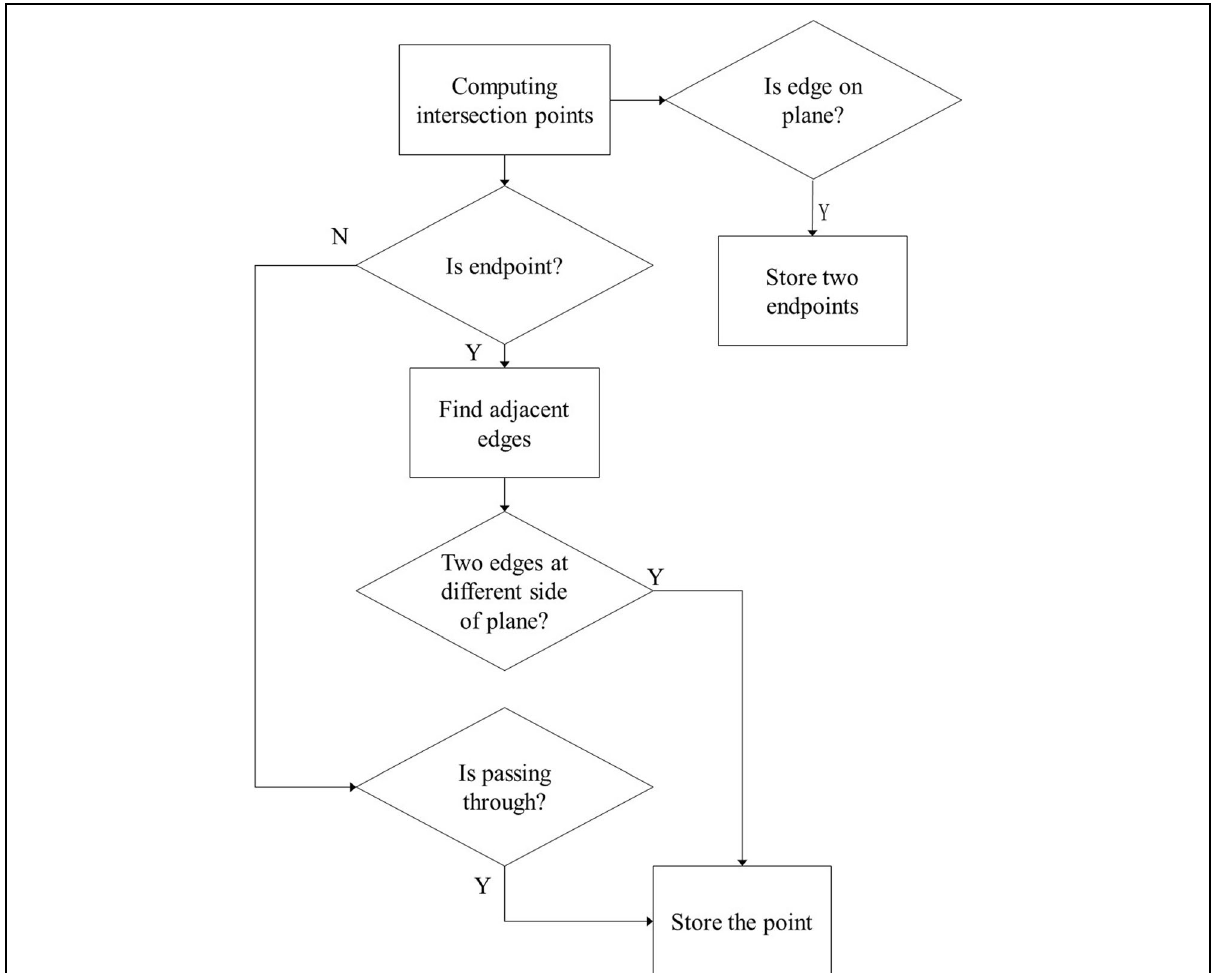
Fig. 4 Flow chat of computing intersection points between edges and a slicing